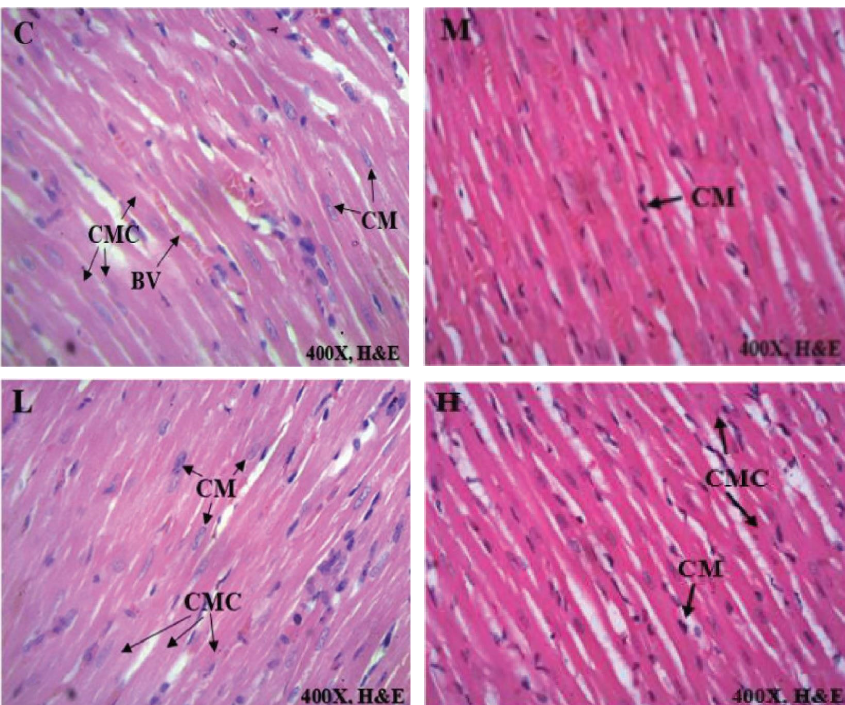
Figure 2: Te efect of AAE on histological features of the heart, with (C) representing control, (L) representing 100mgkg − 1 , (M) representing 300mgkg − 1 , and (H) representing 1000mgkg − 1 . CM-cardiac muscle nuclei, CMC-cardiac muscle cells, BV-blood vessels. Te photomicrographs (H&E, x400) of the heart tissues represent the general appearance observed in rats treated with AAE and the control